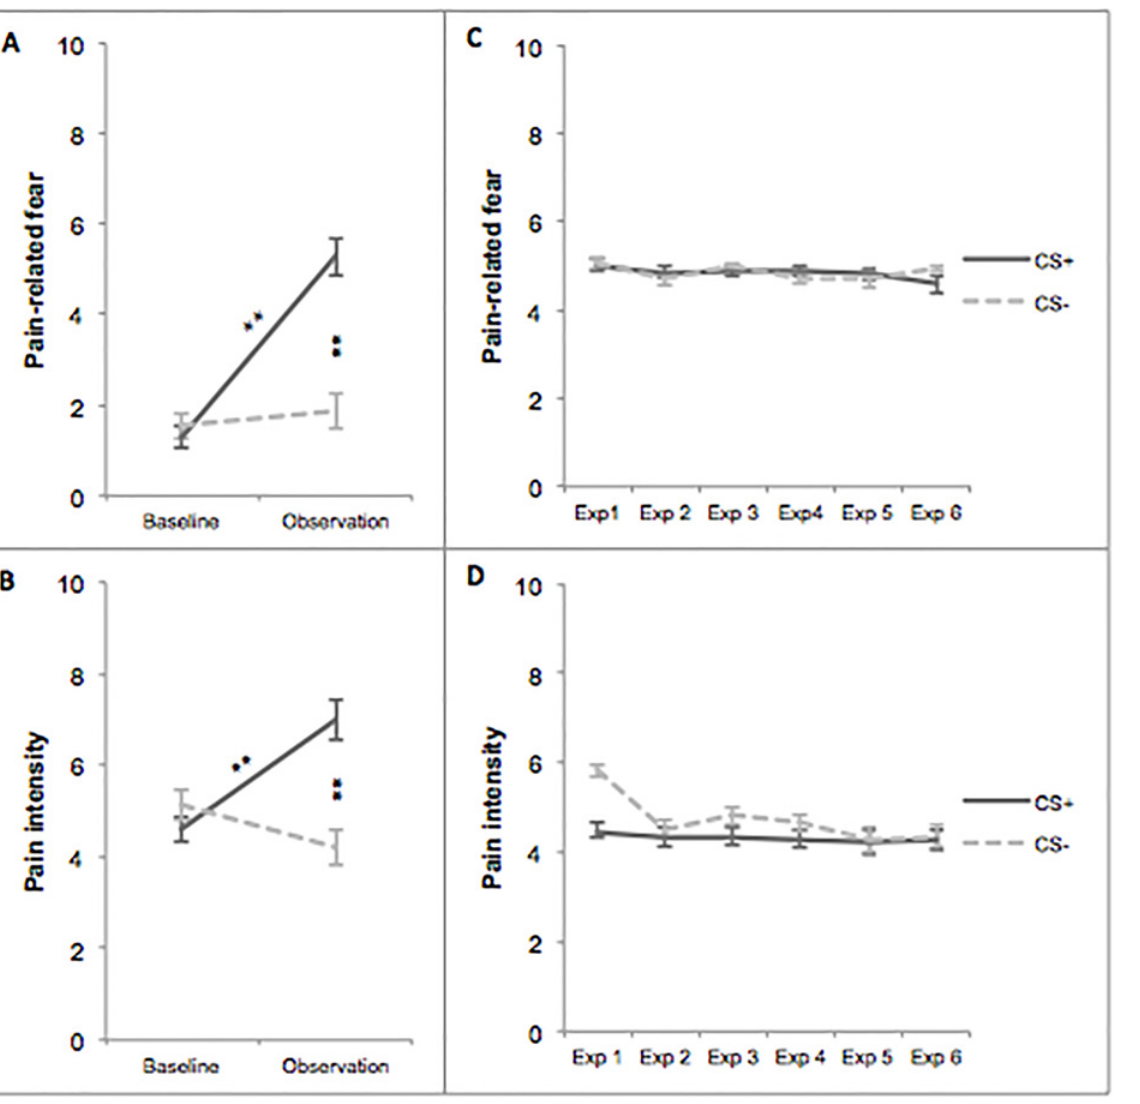
Fig 2. Self-reports: Pain-related fear and pain intensity in Experiment 1. Error bars represent standard errors. Exp = Exposure; * p < .05; ** p <